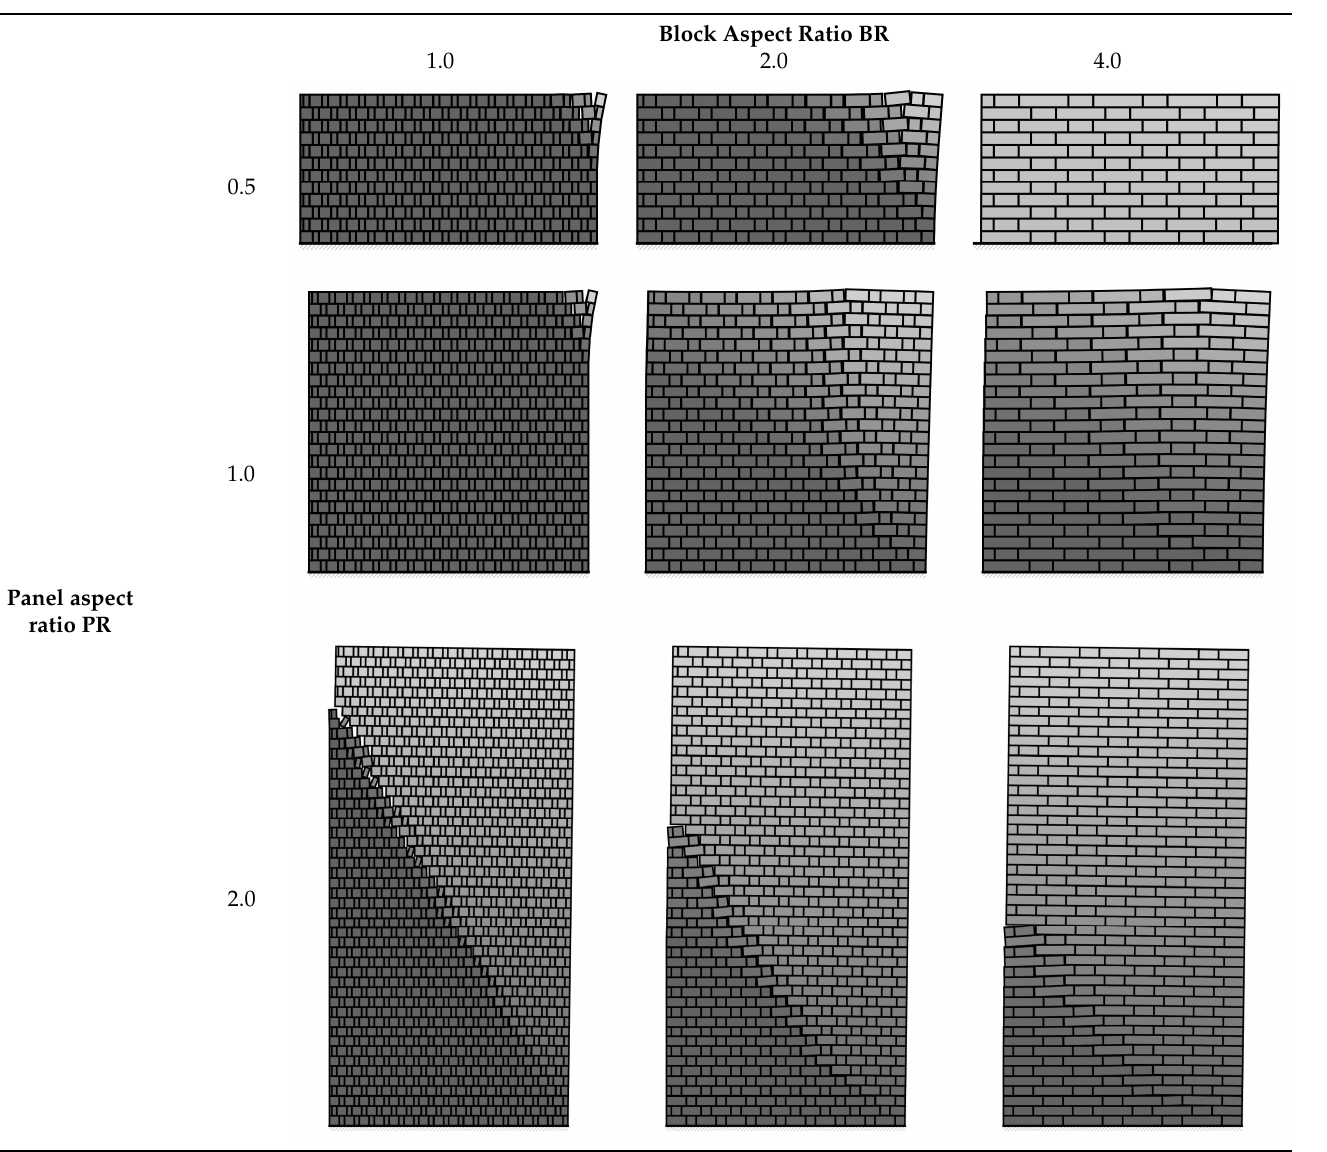
Table A5. Failure Mechanisms for Flemish Bond with µ = 0.65.